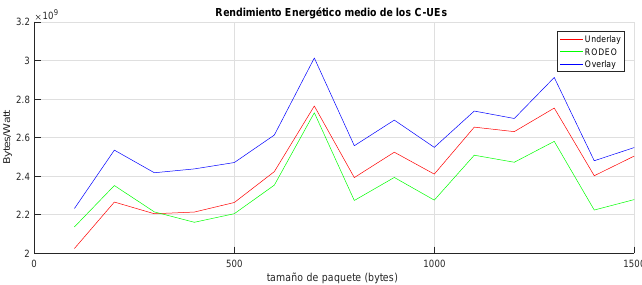
Figure 2. Energy efficiency of C-UEs according to the type of traffic in the C-EU.